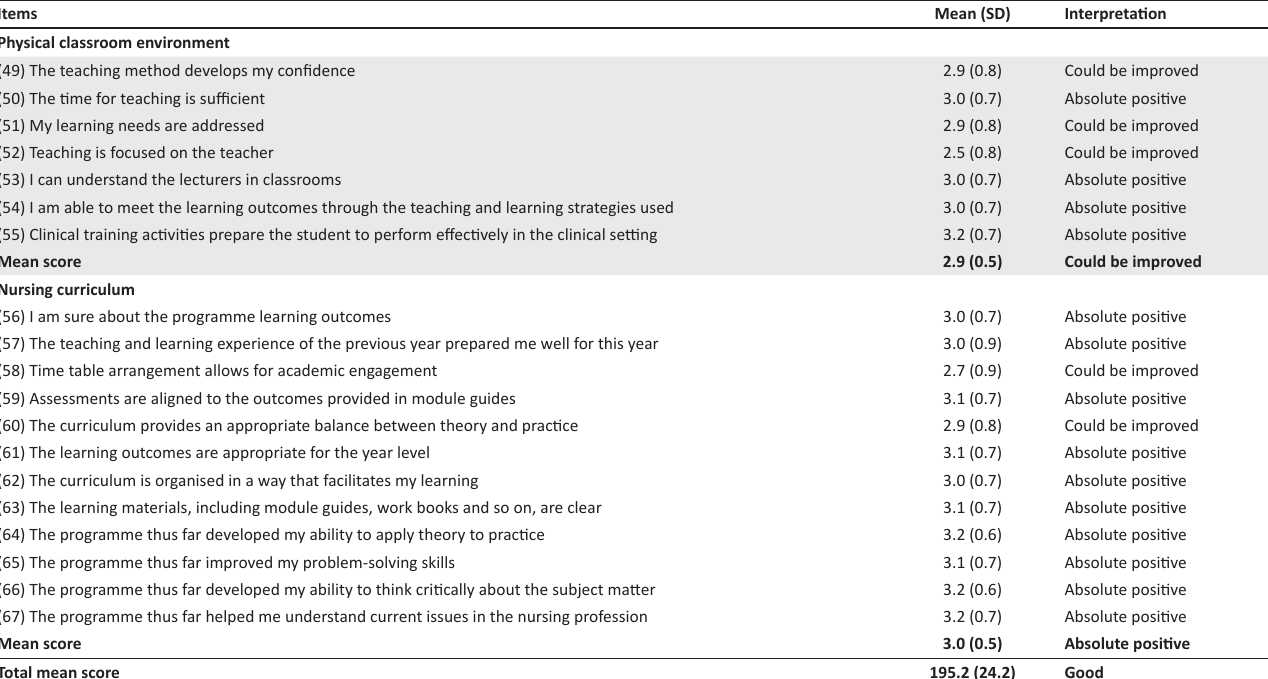
TABLE 5 (Continues...): Mean score (out of 4) of the items under study domains. Items Mean (SD)